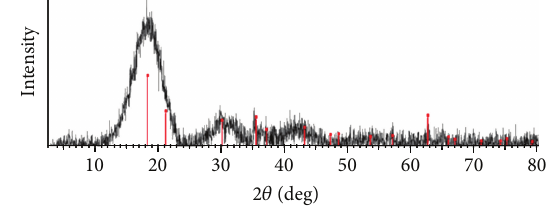
Figure 4: XRD analysis of magnetic copolymer GN73 peaks. Vertical bar is iron oxide standard.